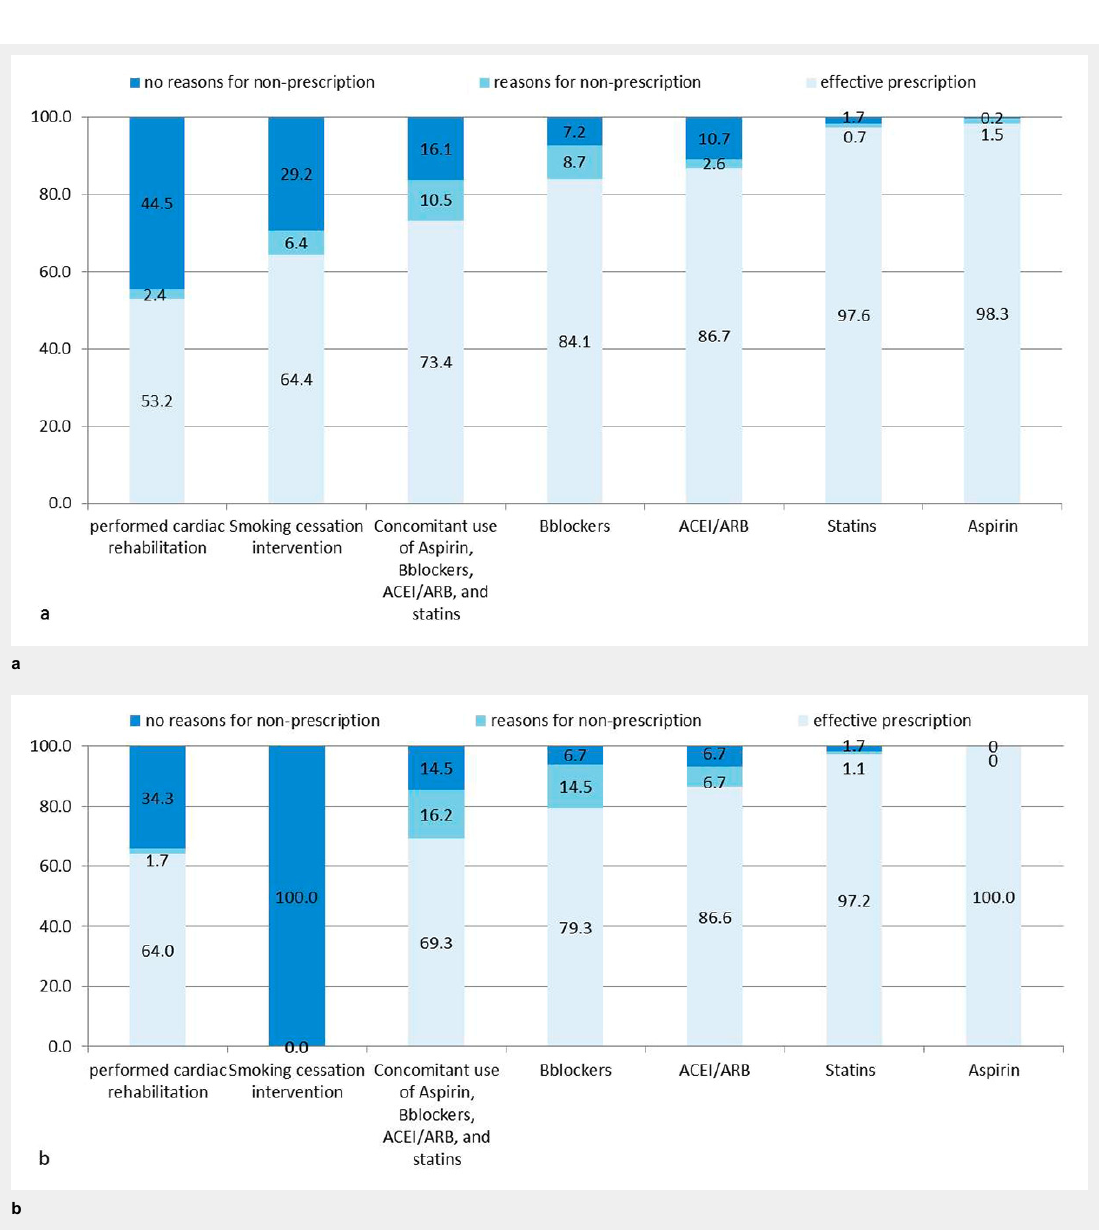
Figure 1 Secondary prevention therapies and interventions with documented contraindications according to presence of PCI facilities. (a) Hospital with PCI facilities. (b) Hospitals without PCI facilities. ACEI = angiotensin converting-enzyme inhibitors; ARB = angiotensin II receptor blockers; Bblockers = β-blockers; PCI = percutaneous coronary